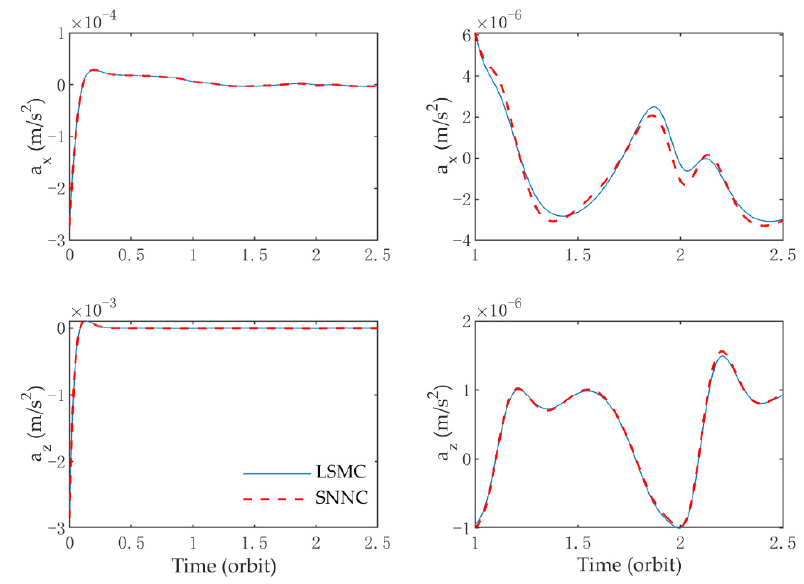
Figure 8. Time histories of control inputs for the case without in-track control.